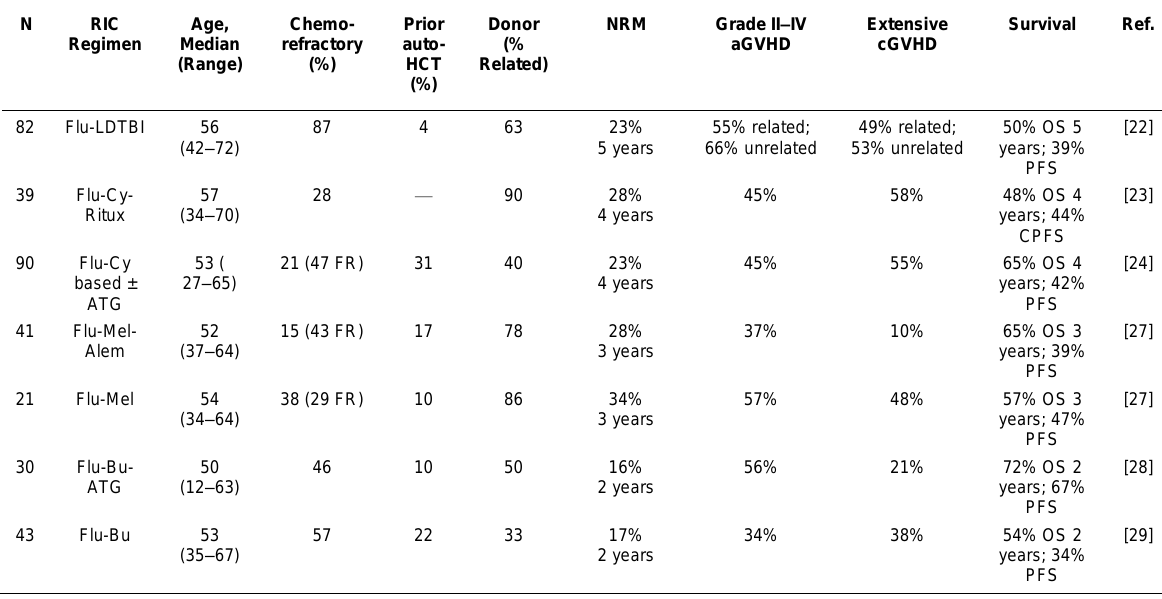
Results of RIC allo-HCT for